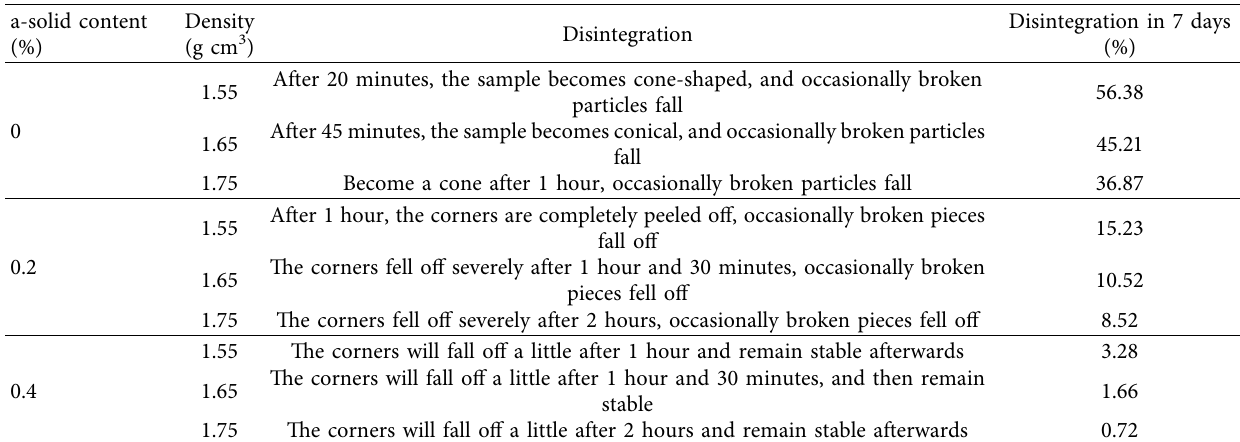
Figure 6: Disintegration process of